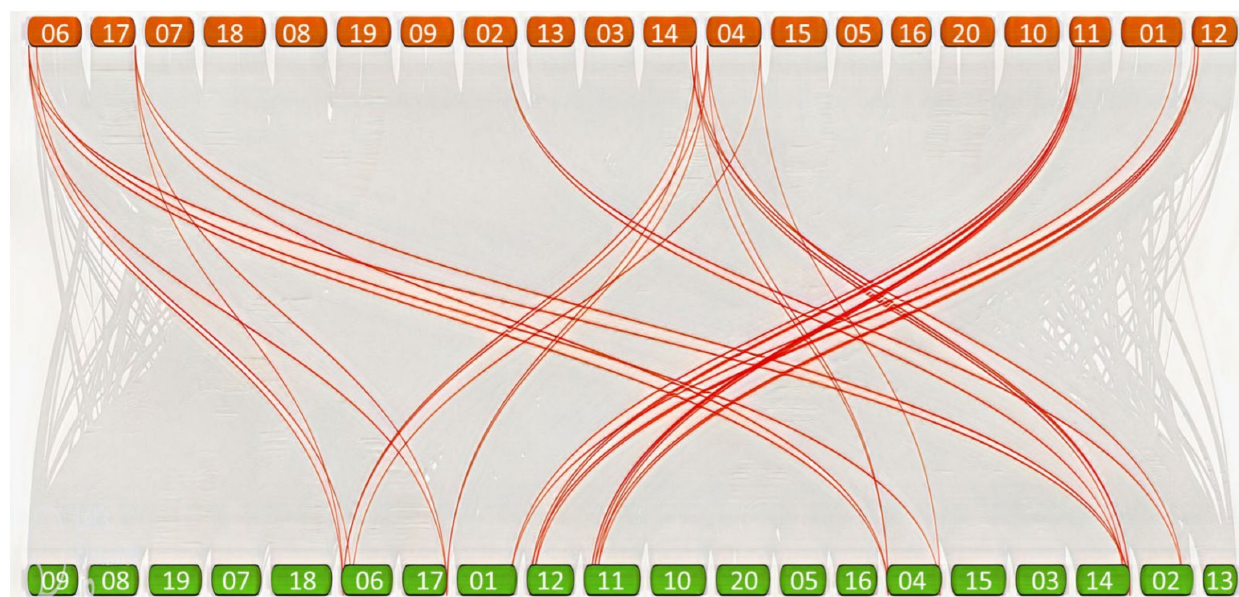
Figure 6. Comparison of APX and CAT genes between G. max and G. soja genomes. A genome scale dual-synteny plot between G. max (green boxes on the bottom side) and G. soja (orange boxes on the upper side) genomes and chromosome number in green and orange boxes, respectively, with APX and CAT genes represented by red